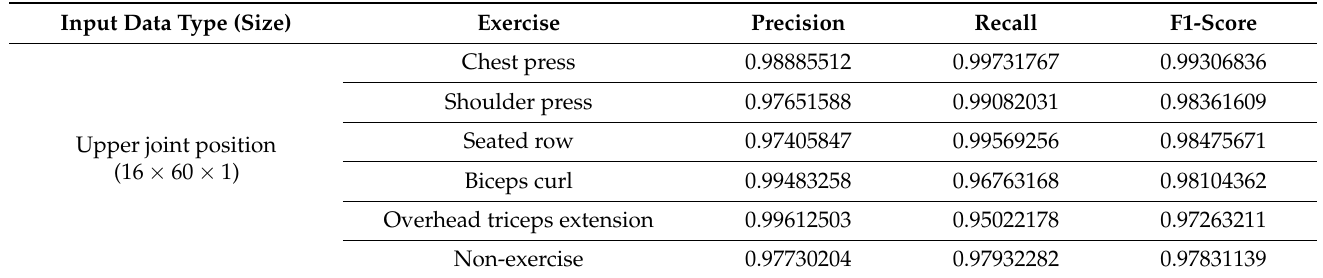
Table 10. Precision, recall, and F1-scores of the upper joint position input model.